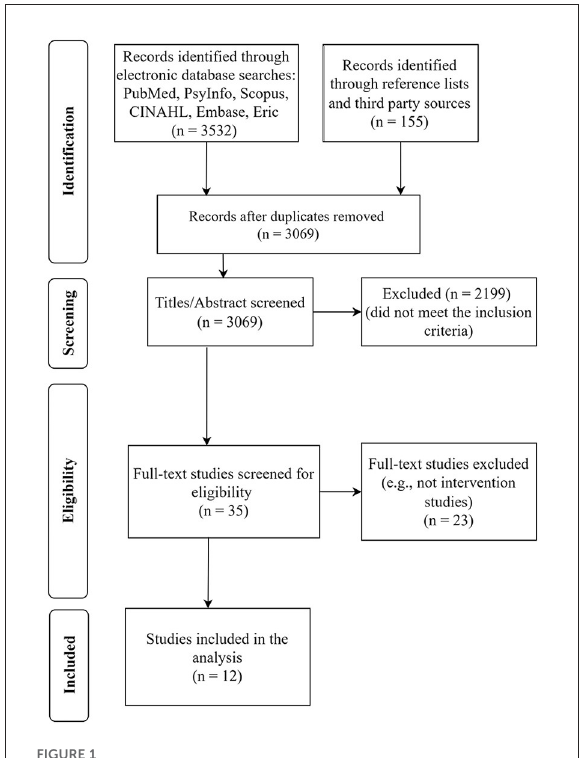
FIGURE1 The flow diagram of the study (adopted from Moher et al.,